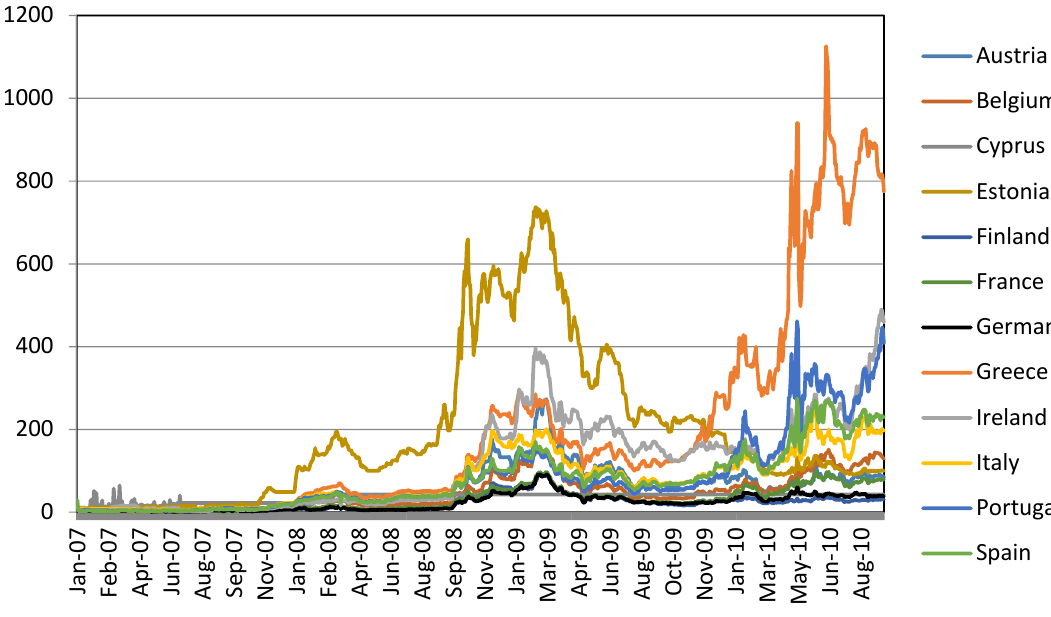
Figure 1. Selected Eurozone sovereign spreads (five-year credit default swap spreads in basis points). Spreads obtained from